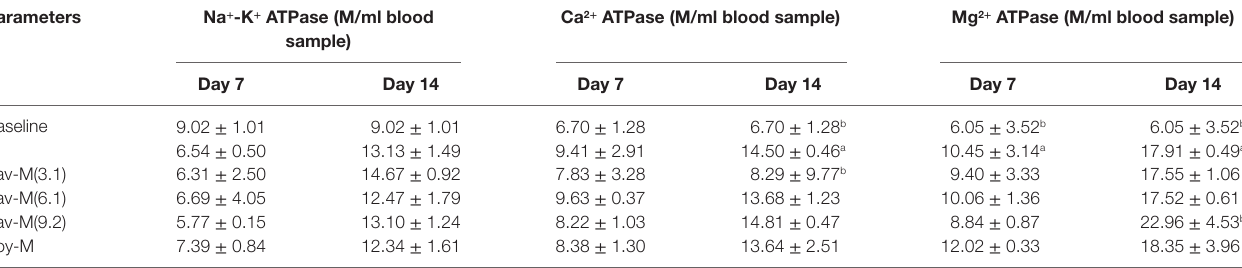
Value = mean ± SD (n = 3). Data within each column with different superscript alphabets are statistically different (P < 0.05). C, control; Pav-M(3.1), group with daily administration of 3.1 µl/g animal wt. pro-milk extract from A. pavonina seed; Pav-M(6.1), group with daily administration of 6.1 µl/g animal wt. pro-milk extract from A. pavonina seed; Pav-M(9.2), group with daily administration of 9.2 µl/g animal wt. pro-milk extract from A. pavonina seed; Soy-M, group with